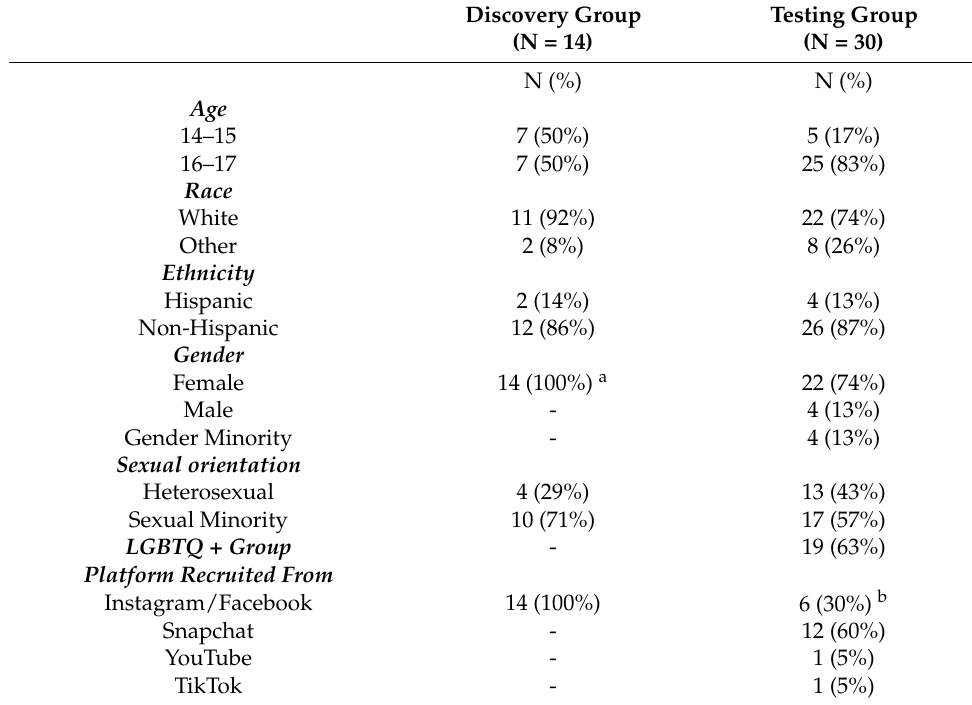
Table 1. Discovery and Testing Group sample